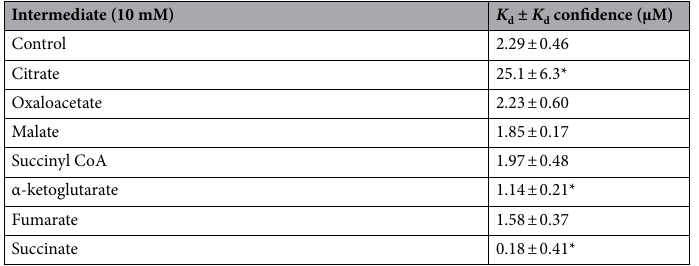
Table 1. Effects of the TCA cycle intermediates on the affinity of the MDH-CS complex Data are presented as K d ± K d confidence. Asterisks represent metabolites that showed significant differences with no K d confidence overlap with the control. The data for citrate, oxaloacetate, and malate are the same as Fig.